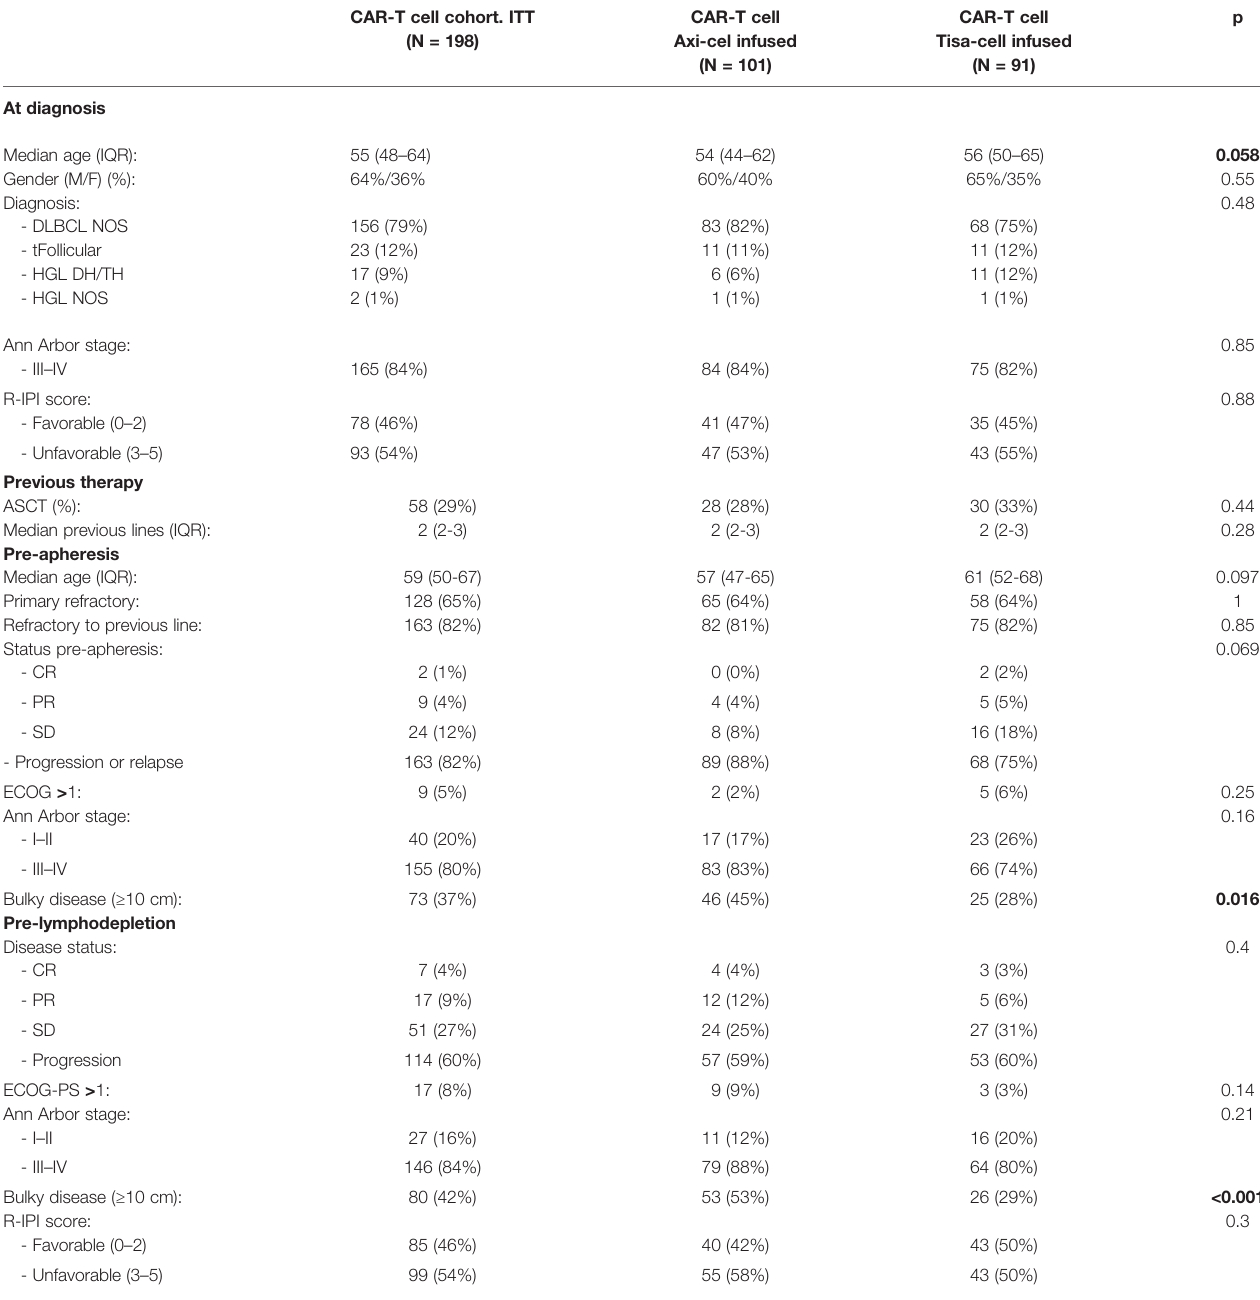
TABLE 3 | CAR-T cell cohort characteristics: intention-to-treat and infused axi-cel and tisa-cel populations. CAR-T cell cohort. ITT CAR-T